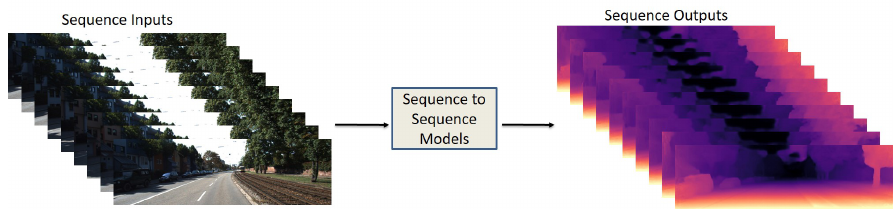
Figure 8. Data input/output structure of sequence-to-sequence models. Sequence of images as an input and sequence of images as an output.